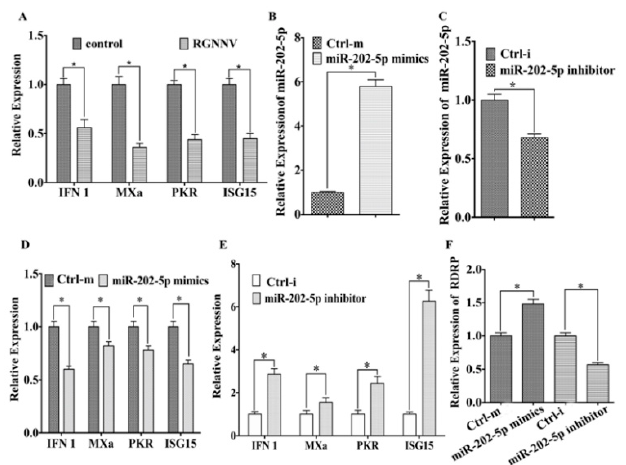
Figure 2. miR-202-5p inhibits antiviral genes expression and promotes RGNNV infection in vitro. ( A ) The expression of IFN 1 , PKR , MXa , and ISG15 mRNA post RGNNV infection. ZBE3 cells were infected with RGNNV (MOI = 1) or uninfected (control) for 24 h, total RNA was extracted for qRT-PCR assays. ( B , C ) E ff ects of miR-202-5p mimics and inhibitor on expression of miR-202-5p. ZBE3 cells were transfected with miR-202-5p mimics and control mimics (Ctrl-m) ( B ) or with miR-202-5p inhibitor and inhibitor control (Ctrl-i) ( C ) for 48 h, and then total RNAs were extracted to examine the expression of miR-202-5p. ( D–F) , E ff ects of miR-202-5p mimics and inhibitor on expression of IFN 1 , PKR , MXa , ISG15, and RGNNV viral RNA-dependent RNA polymerase ( RDRP ). ZBE3 cells were transfected with miR-202-5p mimics and Ctrl-m ( D ) or with miR-202-5p inhibitor and Ctrl-i ( E ) for 24 h before RGNNV infection. At 24 h post RGNNV infection, the expression levels of IFN 1 , PKR , MXa , ISG15 ( D , E ) and RDRP ( F ) were detected by qRT-PCR. The relative expression levels were normalized with 18s rRNA and represented as fold induction relative to the transcription level in the control, which was regarded as 1. Asterisks indicate the significant di ff erences between groups (*: p < 0.05).